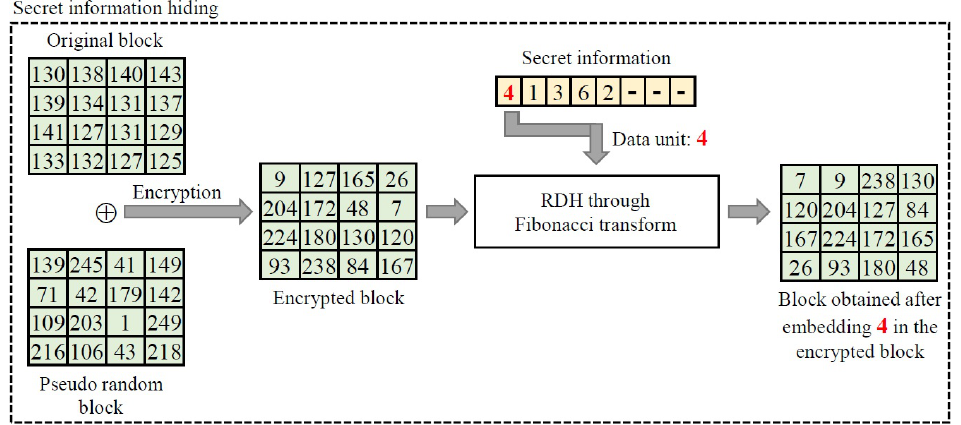
Figure 2. Illustration of data flow when hiding the secret information. Algorithm 2: FibonacciTransfer